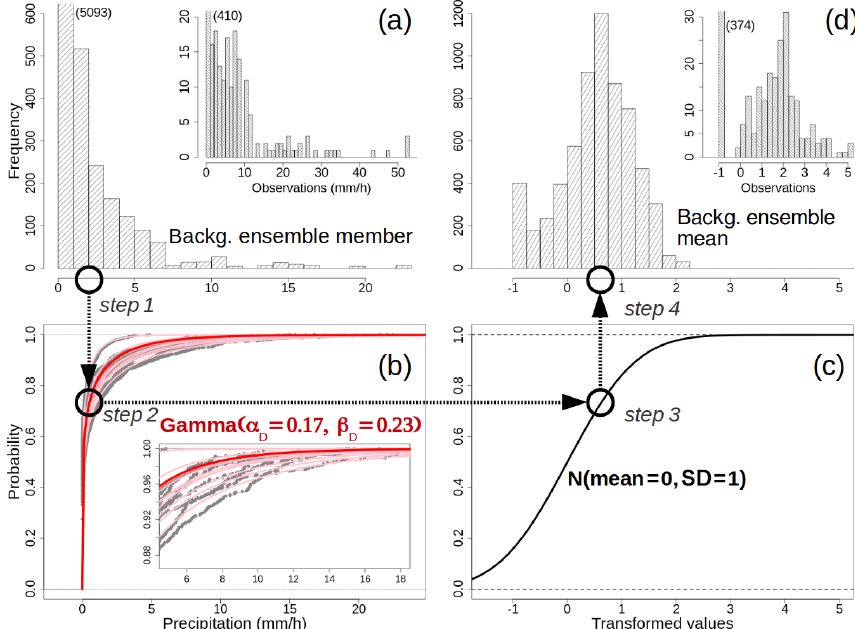
Figure 8. Data transformation procedure. Example for 30 July 2019, 15:00UTC, hourly precipitation totals over Sogn og Fjordane (see Fig. 7). (a) The histograms with the frequencies of occurrence for one member of the ensemble forecast and the observed values. The numbers in parentheses indicate the values of the truncated bins. (b) The cumulative distribution functions (CDFs) for the 10 forecast ensemble members – the empirical CDFs are shown as gray dots, and the best-fitting Gamma CDFs are shown as pink lines. The final Gamma CDF used in the Gaussian anamorphosis is shown with the red line, and the parameters are reported. The inset at the bottom right shows a magnified section of the main graph. (c) The standard Gaussian CDF. (d) The distributions of transformed values for the background ensemble mean and the observations. The four different steps of the data transformation for an arbitrary value of precipitation (approximately 2mmh − 1 ) are indicated by circles and